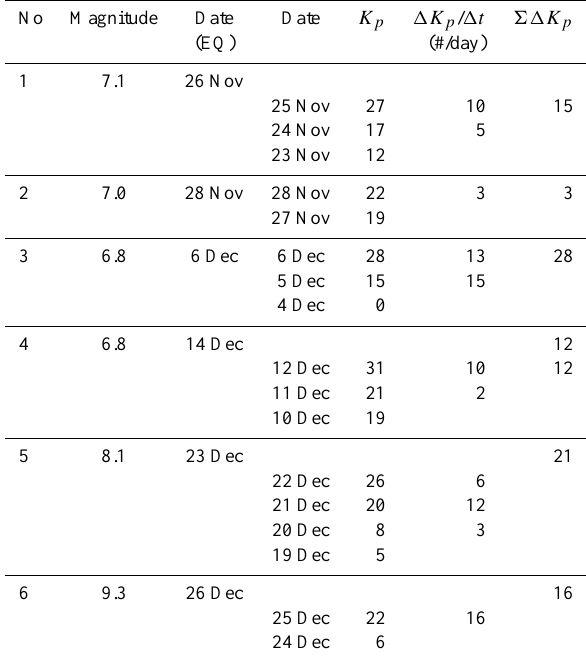
Table 2. The six earthquakes of Fig. 1: magnitude, date of occur- rence, the days of the monotonic K p increase before each of the 6 earthquakes, the values of the increasing K p index before each earthquake, the corresponding index increase over its value of the previous day 1K p / 1t (#/day), and the total increase 61K p during the period (days) of K p index monotonic